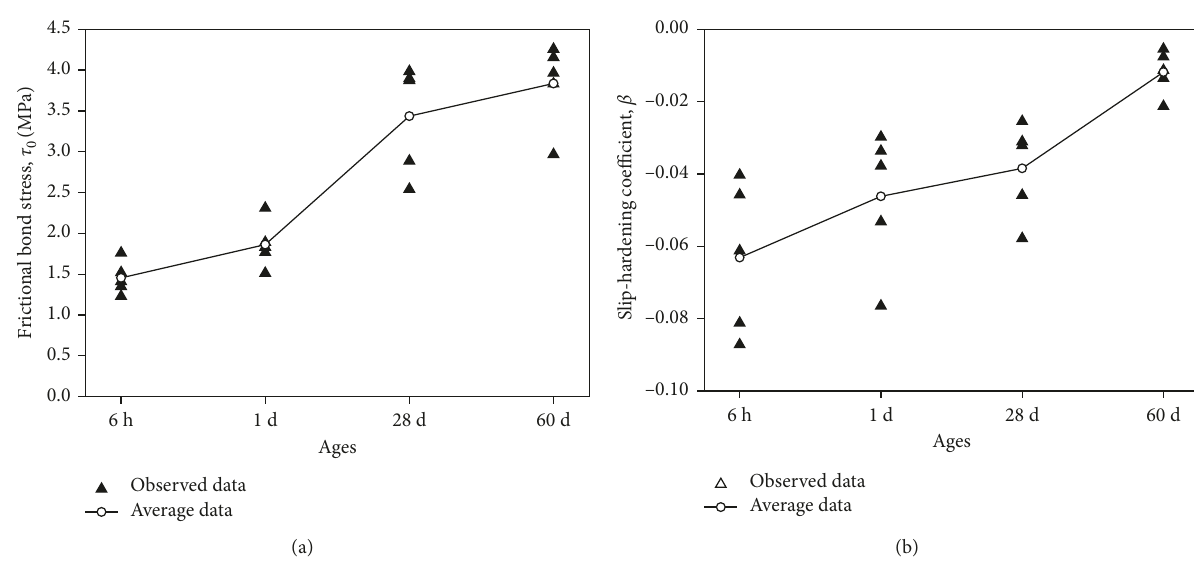
Figure 12: Influence of curing ages on PE fiber/matrix interfacial parameters: (a) τ